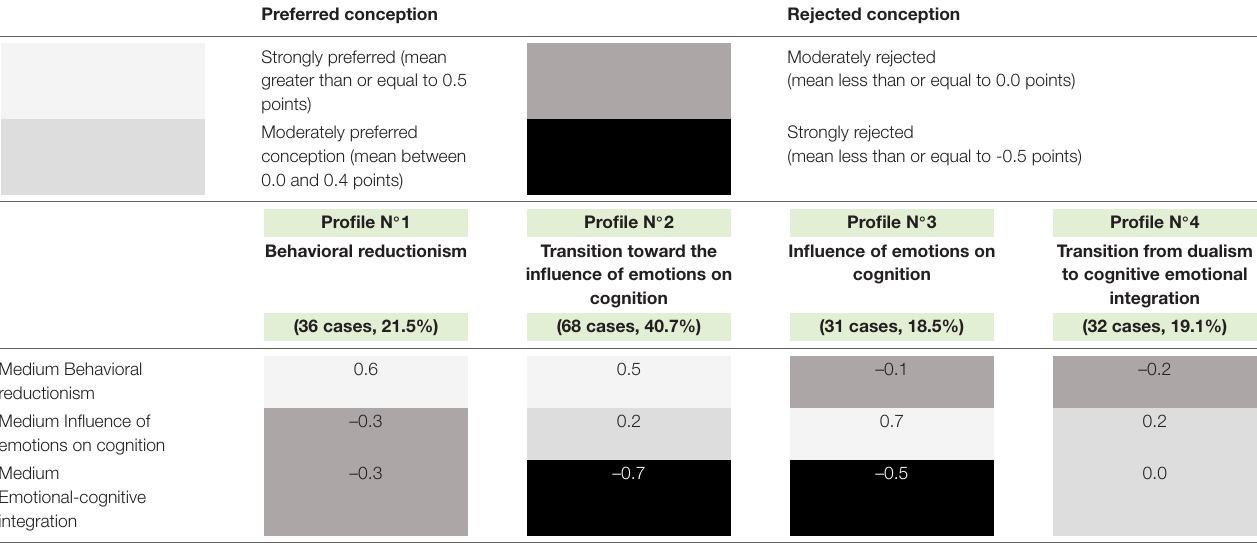
FIGURE 3 | General response trends. TABLE 1 | Conglomerates resulting from the classification with the answers in Scale 1. Preferred conception Rejected